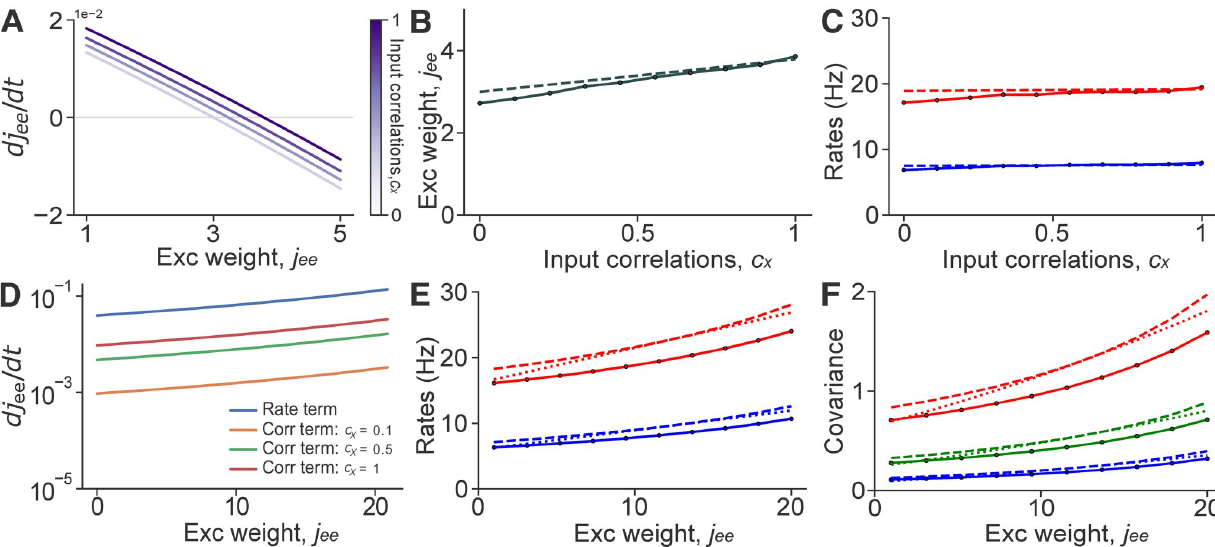
Fig 2. Spike count covariances mildly impact the fixed point of synaptic weights and firing rates. A : The rate of change of EE weights as function of the weight, j ee , at different levels of input correlations, c x . B : Mean steady–state EE synaptic weight for a range of input correlations, c x . C : Mean E and I firing rates as a function of input correlations. D : Same as ( A ) but for an EE STDP rule with all coefficients involving order 2 interactions set equal to 1, and all other coefficients set equal to zero. E : Mean E and I firing rates as a function of mean EE synaptic weights. F : Mean spike count covariances between E spike trains, I spike trains, and between E – I spike trains as a function of EE synaptic weight, j ee . Solid lines represent simulations (except in A , D ), dashed lines are values obtained from theory (Eqs (3), (5) and (21)), and dotted lines were obtained from the perturbative analysis. Note that in all panels, ‘Exc weight’ refers to j ee rather than J ee , as the former does not depend on N